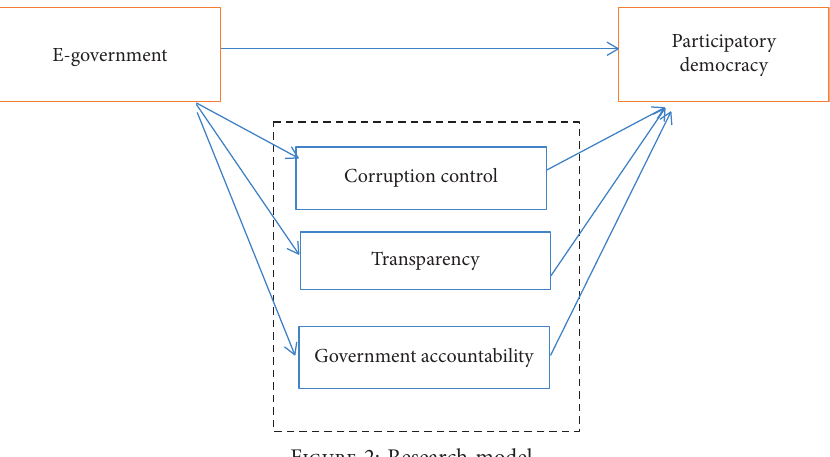
Figure 2: Research